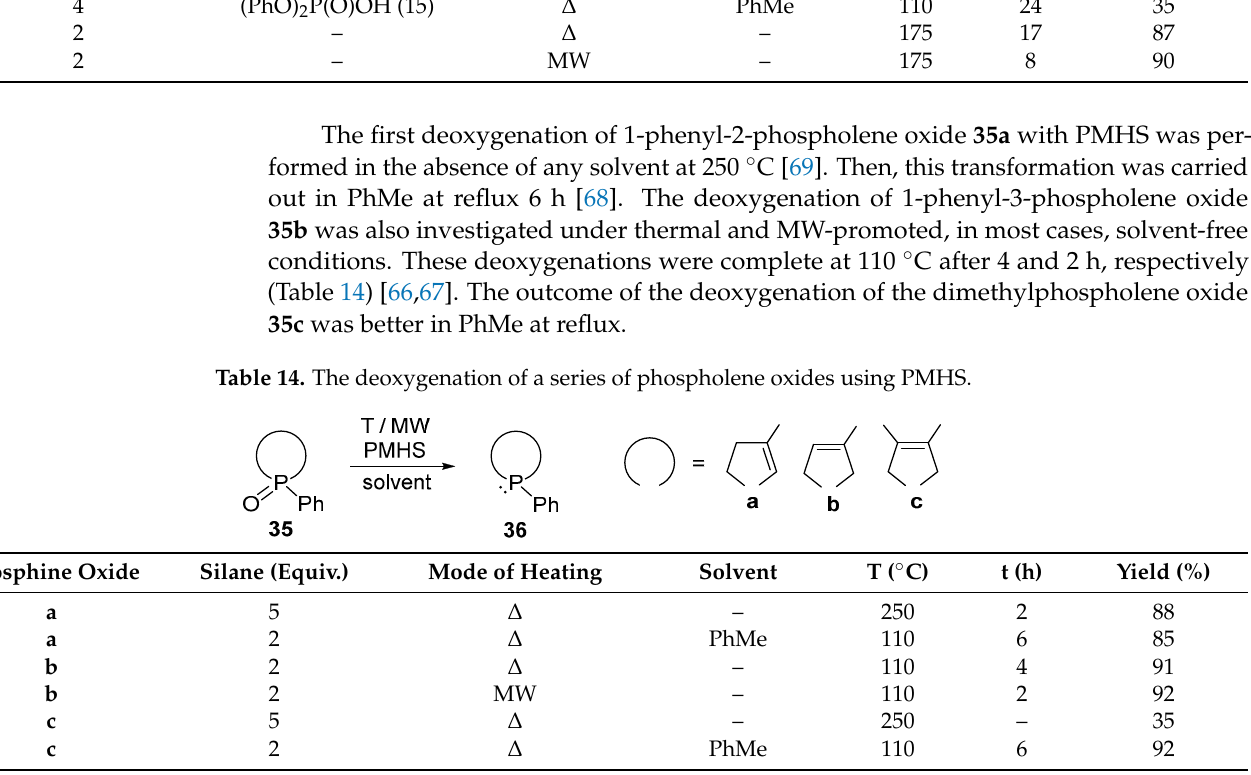
Equivalent of PMHS